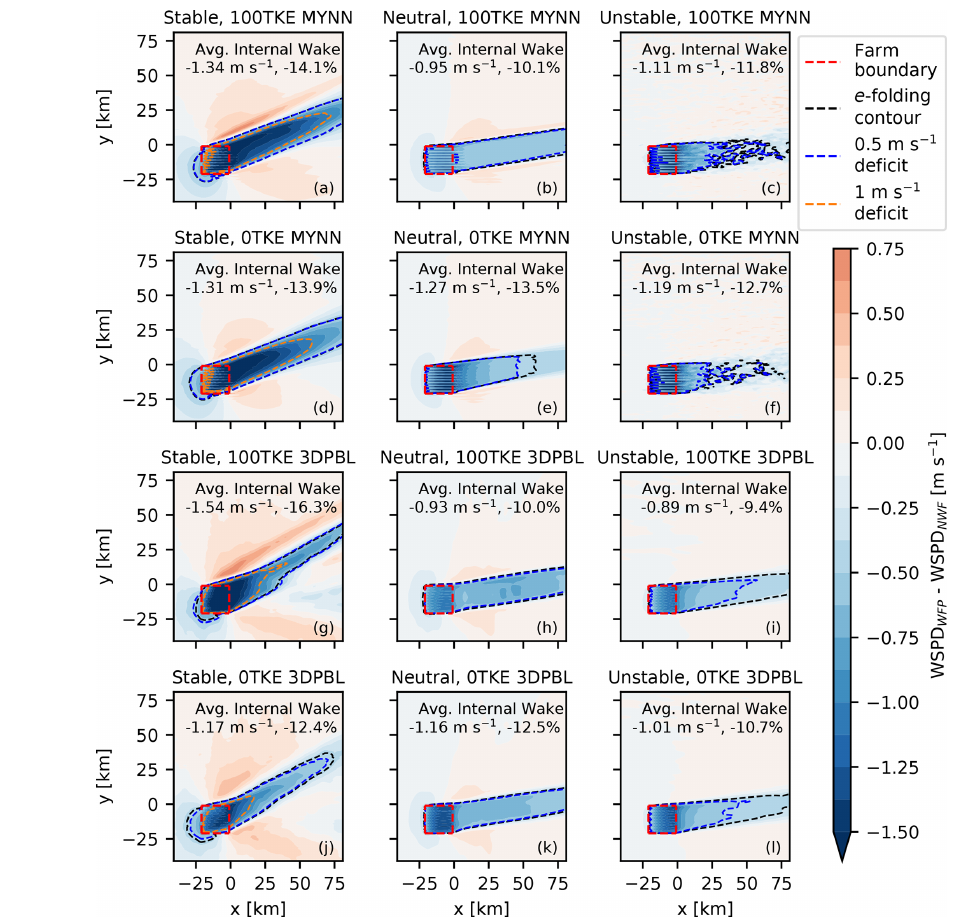
Figure 3. Hub-height wind speed deficits in varying stabilities (left–right) and PBL configurations (up–down). Average hub-height wind speed deficits inside the plant are noted – in both absolute magnitude and as a percentage relative to the NWF winds. The 1ms − 1 deficit contour is highlighted only for the stable simulations, as it obscures internal wakes for other stabilities. Wakes are rotated from the u - geostrophic wind due to the combination of friction and the Coriolis